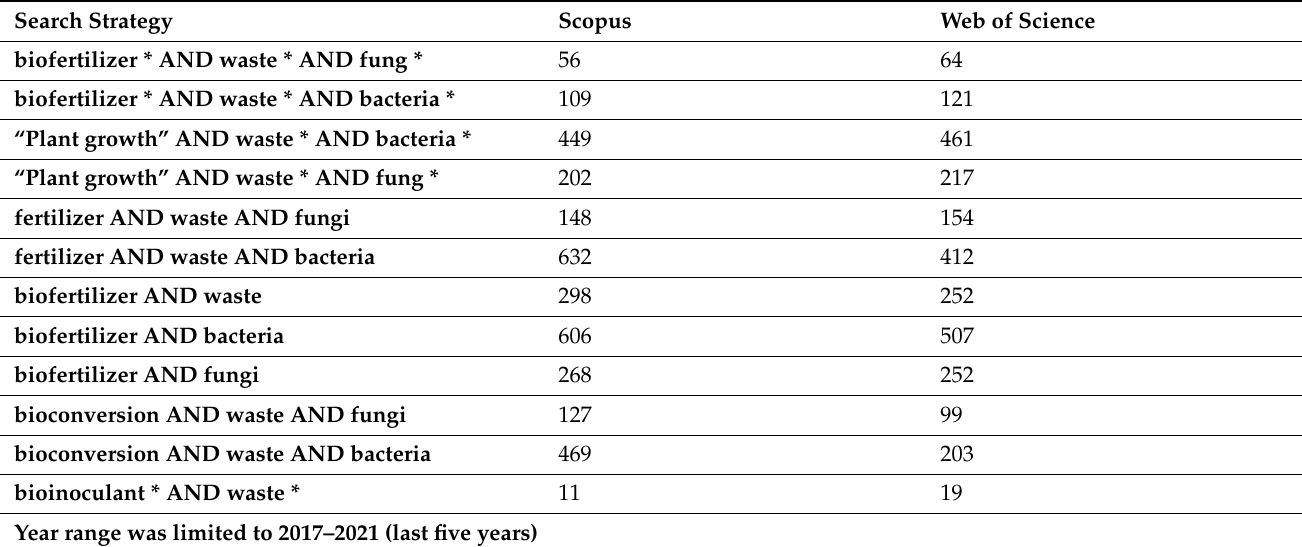
Table 1. Search strategy used to retrieve relevant research